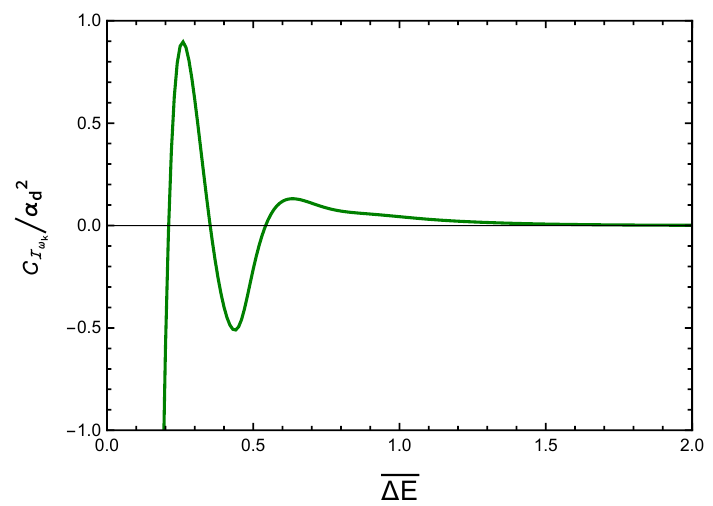
, signifying the concurrence, is plotted for two outgoing null Figure 17 . The quantity C I /α 2 d ωk detectors in a (1 + 1) dimensional de Sitter spacetime with respect to the dimensionless transition energy ∆ E of the detectors for fixed dimensionless frequency of the field ω d/α d = 1